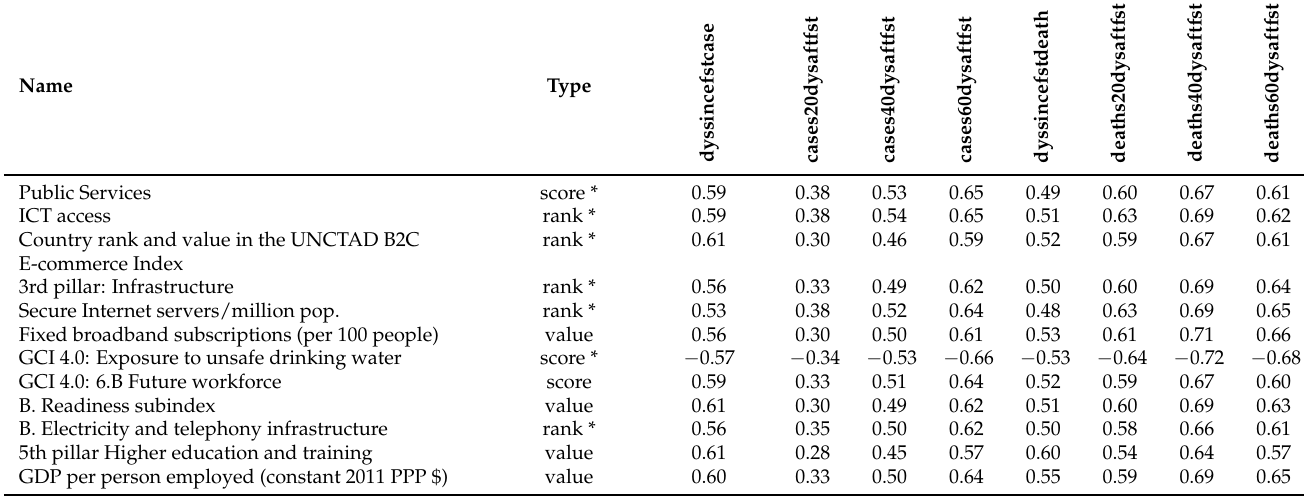
Table A2. Standalone correlations in the infrastructure and digitalization community. Spearman rank correlations between COVID-19 variables and indicators of the infrastructure and digitalization community in the worldwide